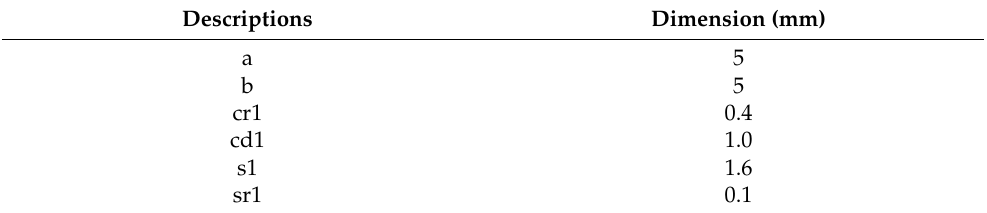
Table 5. Dimension details of all four elements for two-bit coding metamaterials.